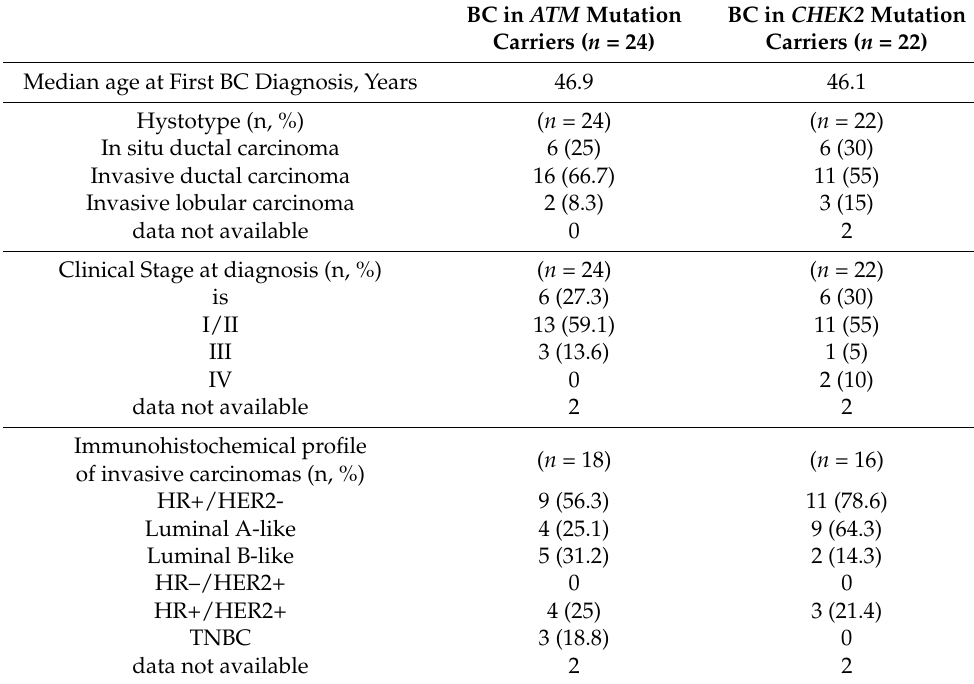
Table 3. Patient and tumor